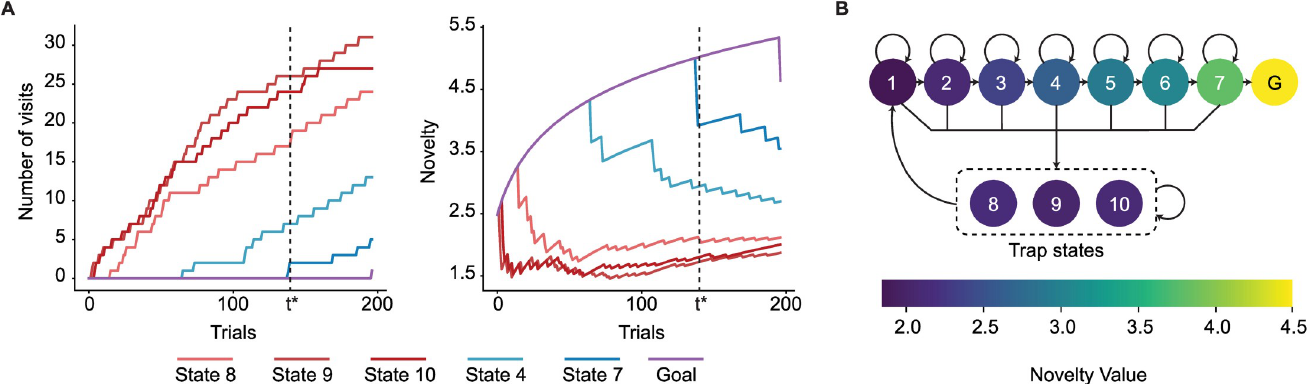
Fig 3. Novelty in episode 1 of block 1. A . The number of state visits (left panel) and novelty (right panel) as a function of time for one representative participant: The number of visits increases rapidly for the trap states and remains 0 for a long time for the states closer to the goal. Novelty of each state is defined as the negative log- probability of observing that state (see Eqs 1 and 2) and, hence, increases for states which are not observed as time passes. The first time participants encounter state 7 (the state before the goal state) is denoted by t � . B . Average (over participants) novelty (color coded) at t � : Novelty of each state is a decreasing function of its distance from the goal